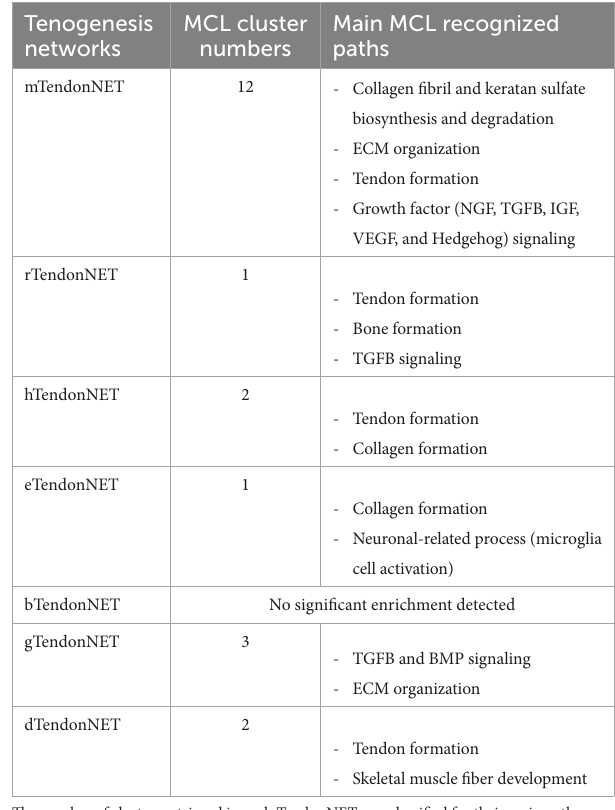
TABLE 2 Tenogenesis network flow definition by MCL-clustering